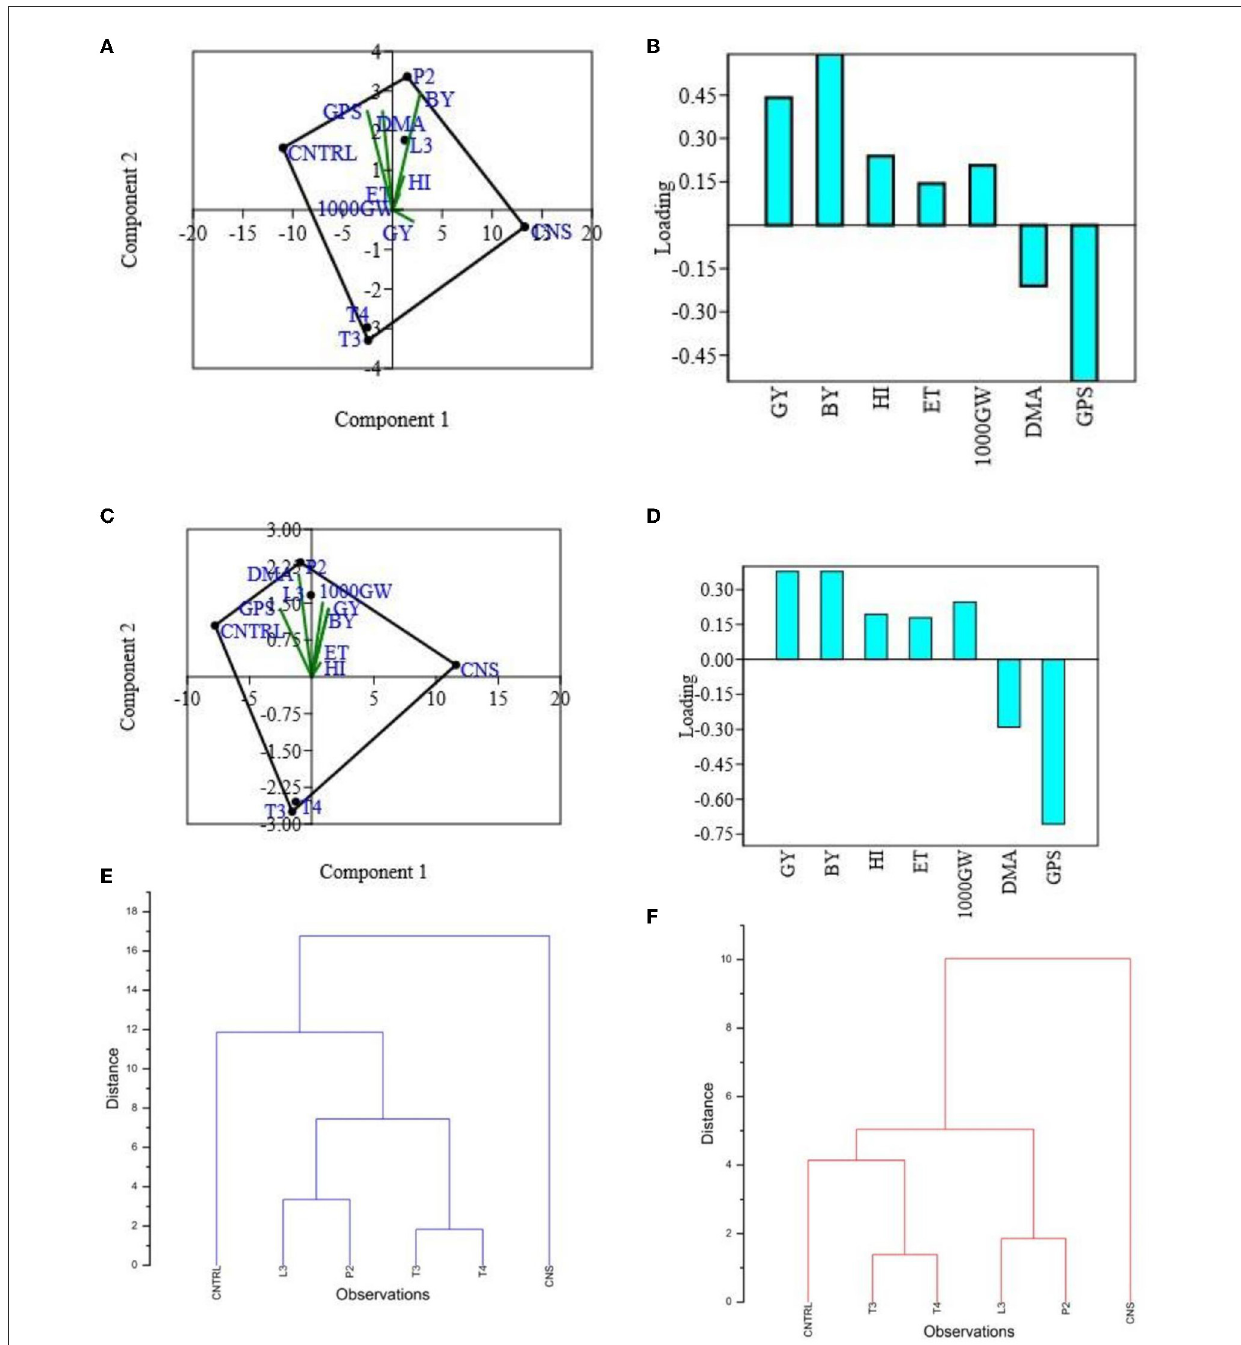
FIGURE5 PCA (A) and loading plot (B) of plant vigor PSB treatments of type field set 1, PCA plot (C) and loading plot (D) of plant vigor PSB treatments in the field set 2, and hierarchal cluster analysis of PSB treatment in the field set 1 (E) and in the field set 2 (F) .